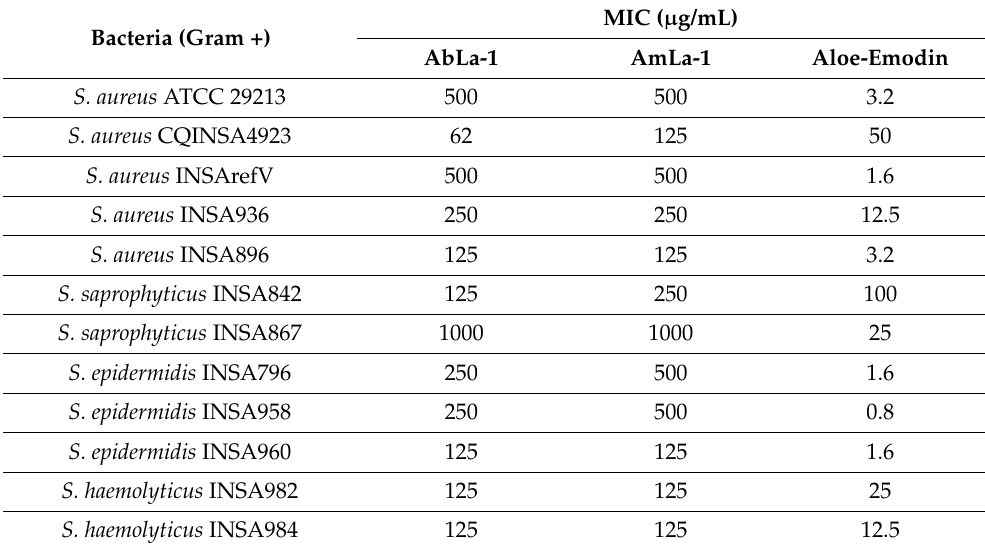
Table 4. In vitro antimicrobial activity of A. bento-rainhae and A. macrocarpus leaf etheric L-L partition extracts against Gram-positive